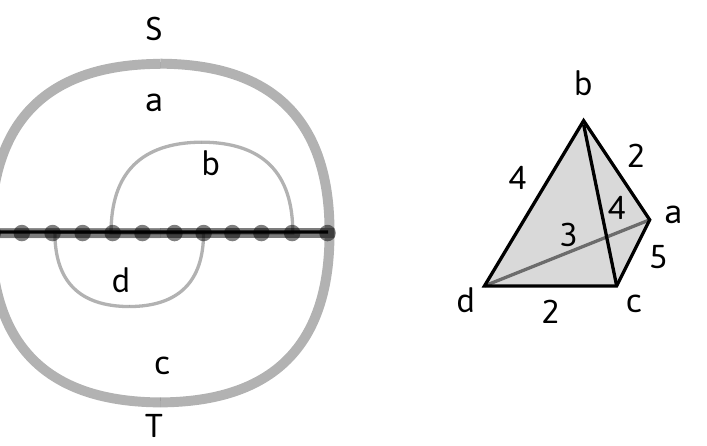
Figure 3. Left: a bi-structure R = ( S , T ) with S -loops a , b , S -rainbow arc α a , T -loops c , d , and T -rainbow arc α c . Right: its weighted loop nerve K 0 ( R ) = { a , b , c , d } , K 1 ( R ) =